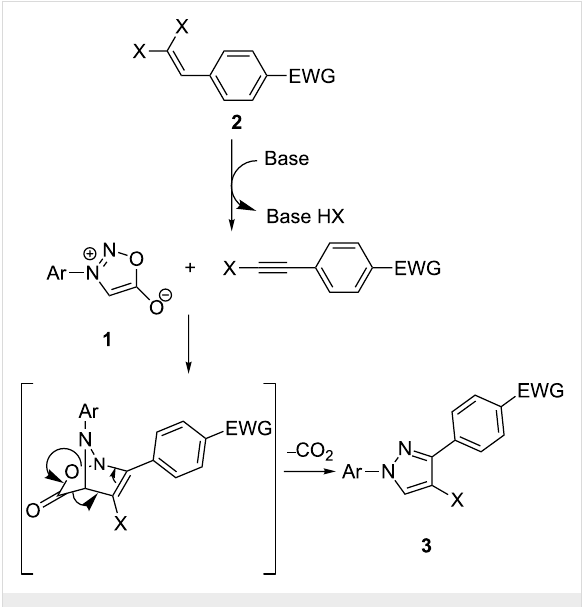
Scheme 2: Proposed mechanism for the synthesis of 3